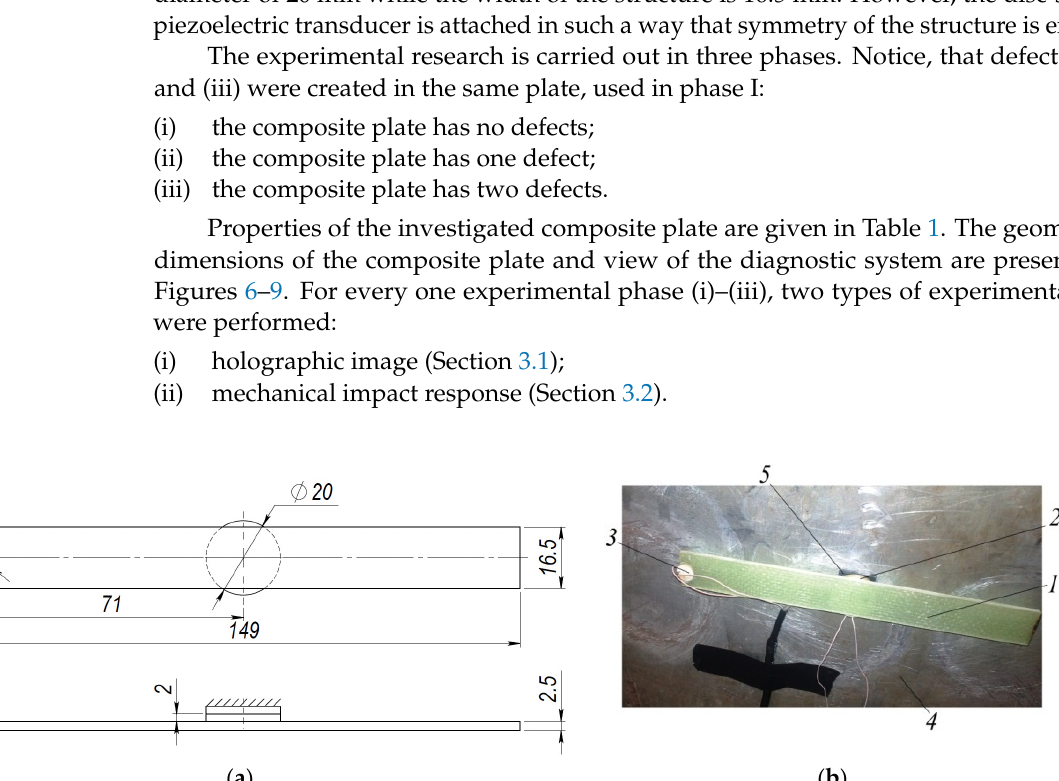
( b ) ( c ) Figure 7. Details of the composite plate with defect: ( a ) Dimensions of the composite plate with one defect; ( b ) Dimensions of the composite plate with two defects; ( c ) View of the composite plate with one defect: 1—composite plate, 2—disc- shaped piezoelectric transducer (as the actuator) for exciting the structure, 3—piezoelectric transducer (as the sensor) for plate vibration measurement, 4—aluminum base, 5—defect, 6—soft material isolation layer between piezoelectric actuator and aluminum plate.